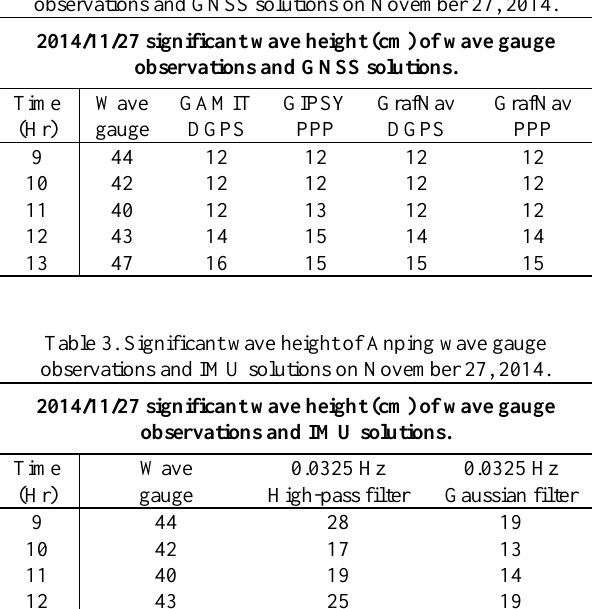
Figure 11(a). FFT power spectrum of GNSS solutions